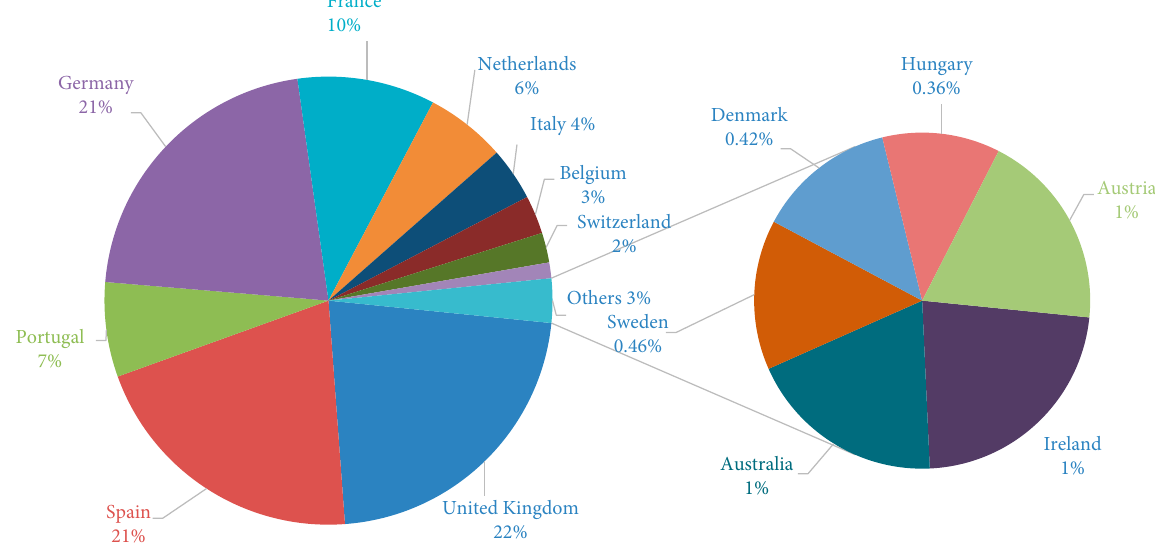
Figure 2: Percentage of total cases of human monkeypox disease in European countries (data presented from May 7, 2022, to July 7, 2022). The countries with less than 20 cases and their percentages are presented under other